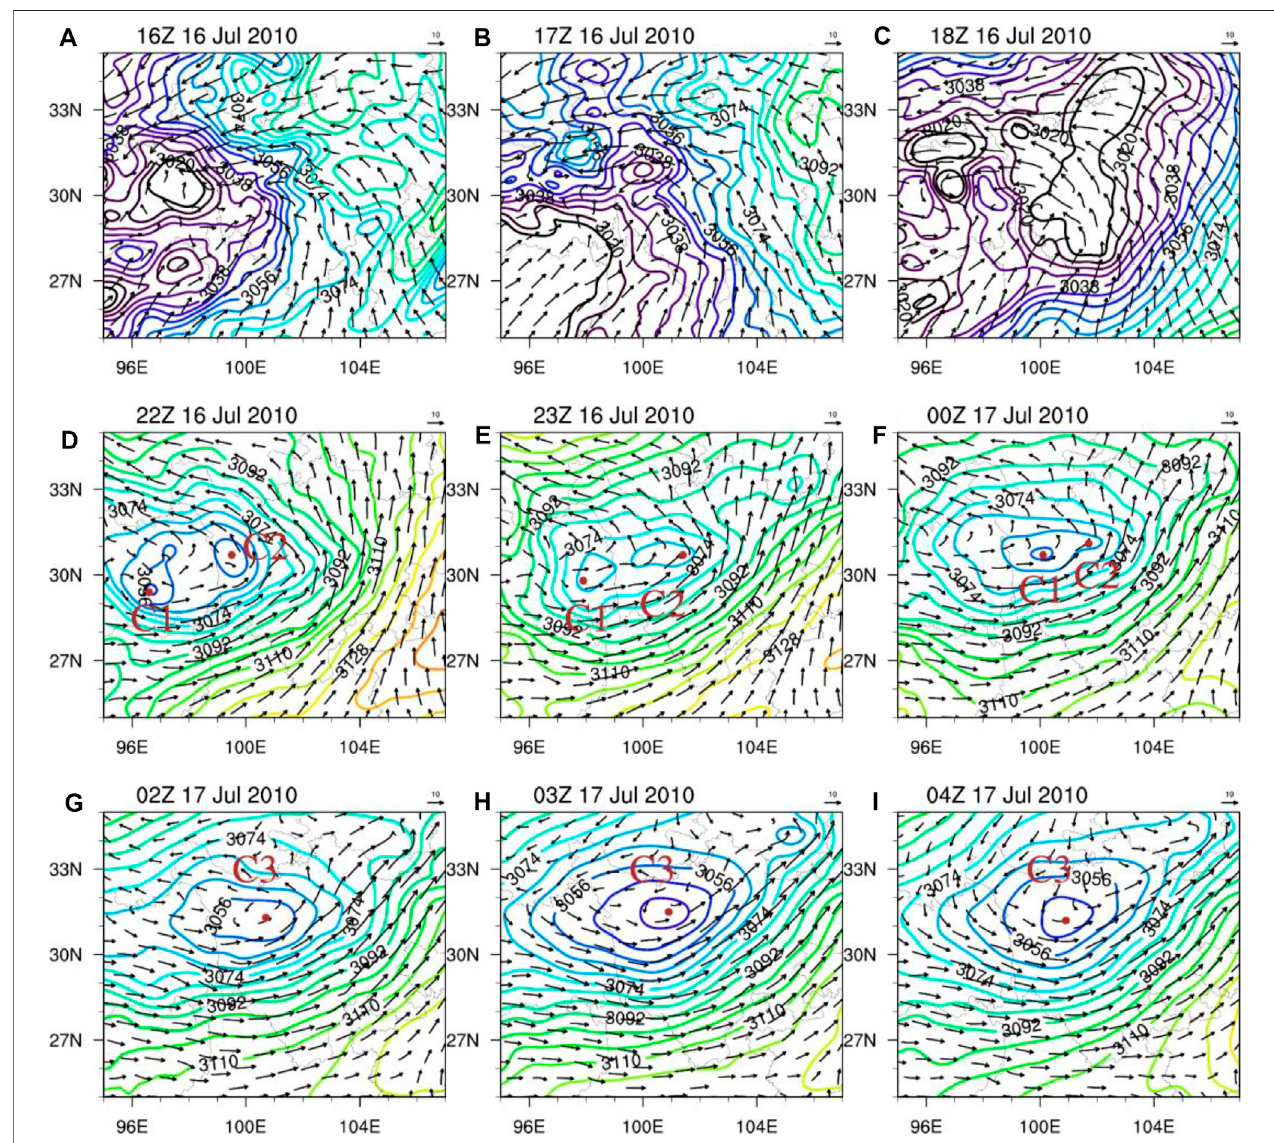
FIGURE 13 | 700 hPa geopotential height (gpm, contours) and wind fi eld (m s − 1 , arrows) for the NOTER experiment at (A) 16:00 UTC July 16, (B) 17:00 UTC July 16, (C) 18:00 UTC July 16, (D) 22:00 UTC July 16 (E) 23:00 UTC July 16, (F) 00:00 UTC July 17, (G) 02:00 UTC July 17, (H) 03:00 UTC July 17, and (i) 04:00 UTC July